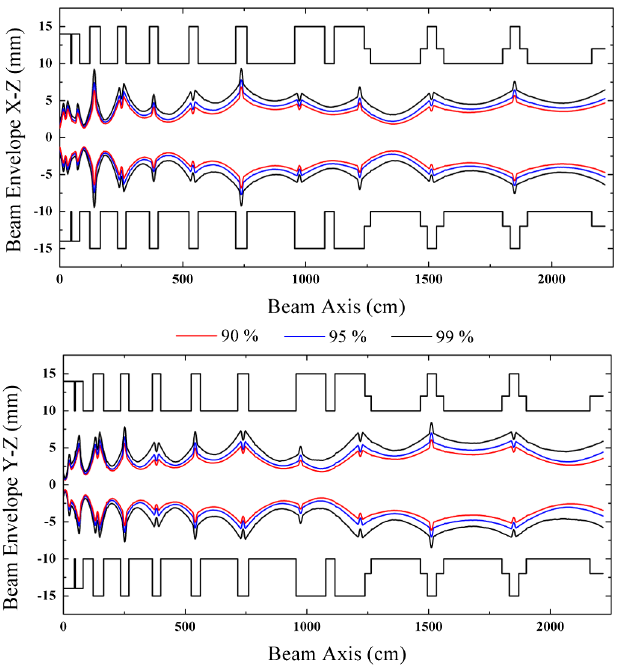
scheme.FIG. 33. The transverse beam envelopes of the FAIR proton